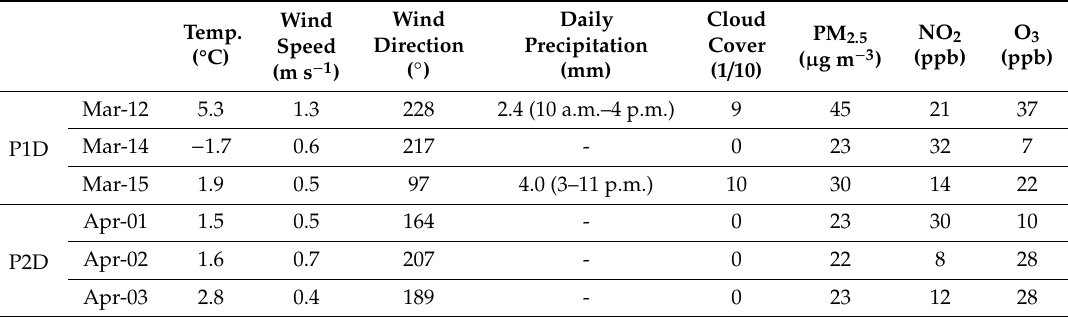
Table 3. Daily meteorological and urban air quality data during the morning rush hours (8–9 a.m.) for the P1D and P2D periods. The wind direction increases clockwise from 0 ◦ (i.e., due north). The daily precipitation amounts are indicated together with the precipitation time.